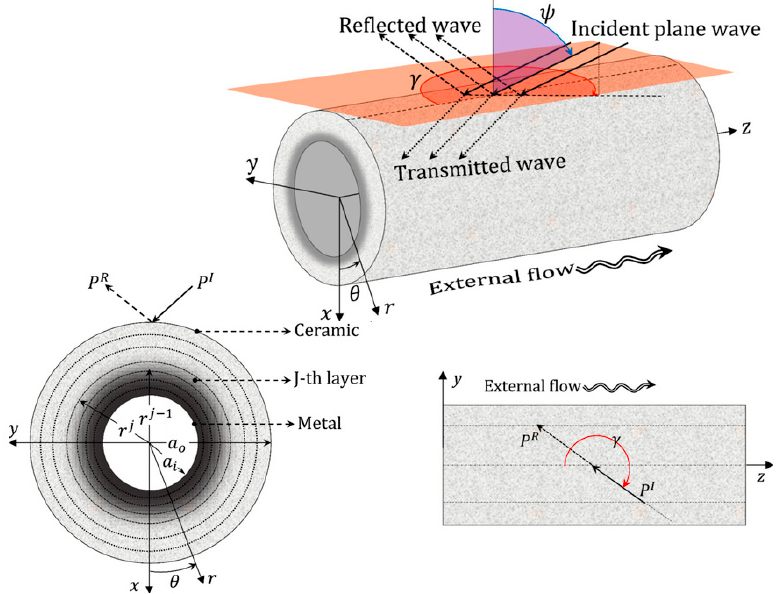
Figure 8. Functionally graded multi-layered cylindrical/curved wall [33] (reproduced with permission from Daneshjou et al. International Journal of Mechanical Sciences; published by Elsevier, 2017).